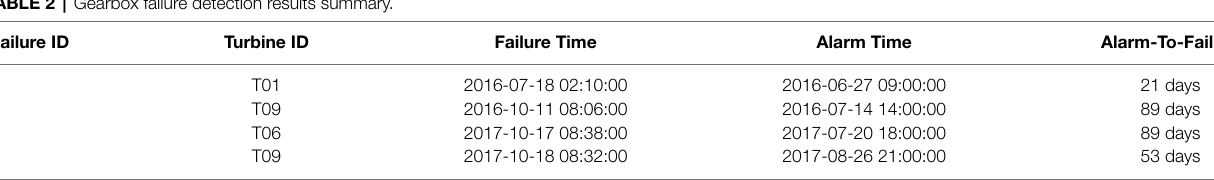
TABLE 3 | Calculated savings from